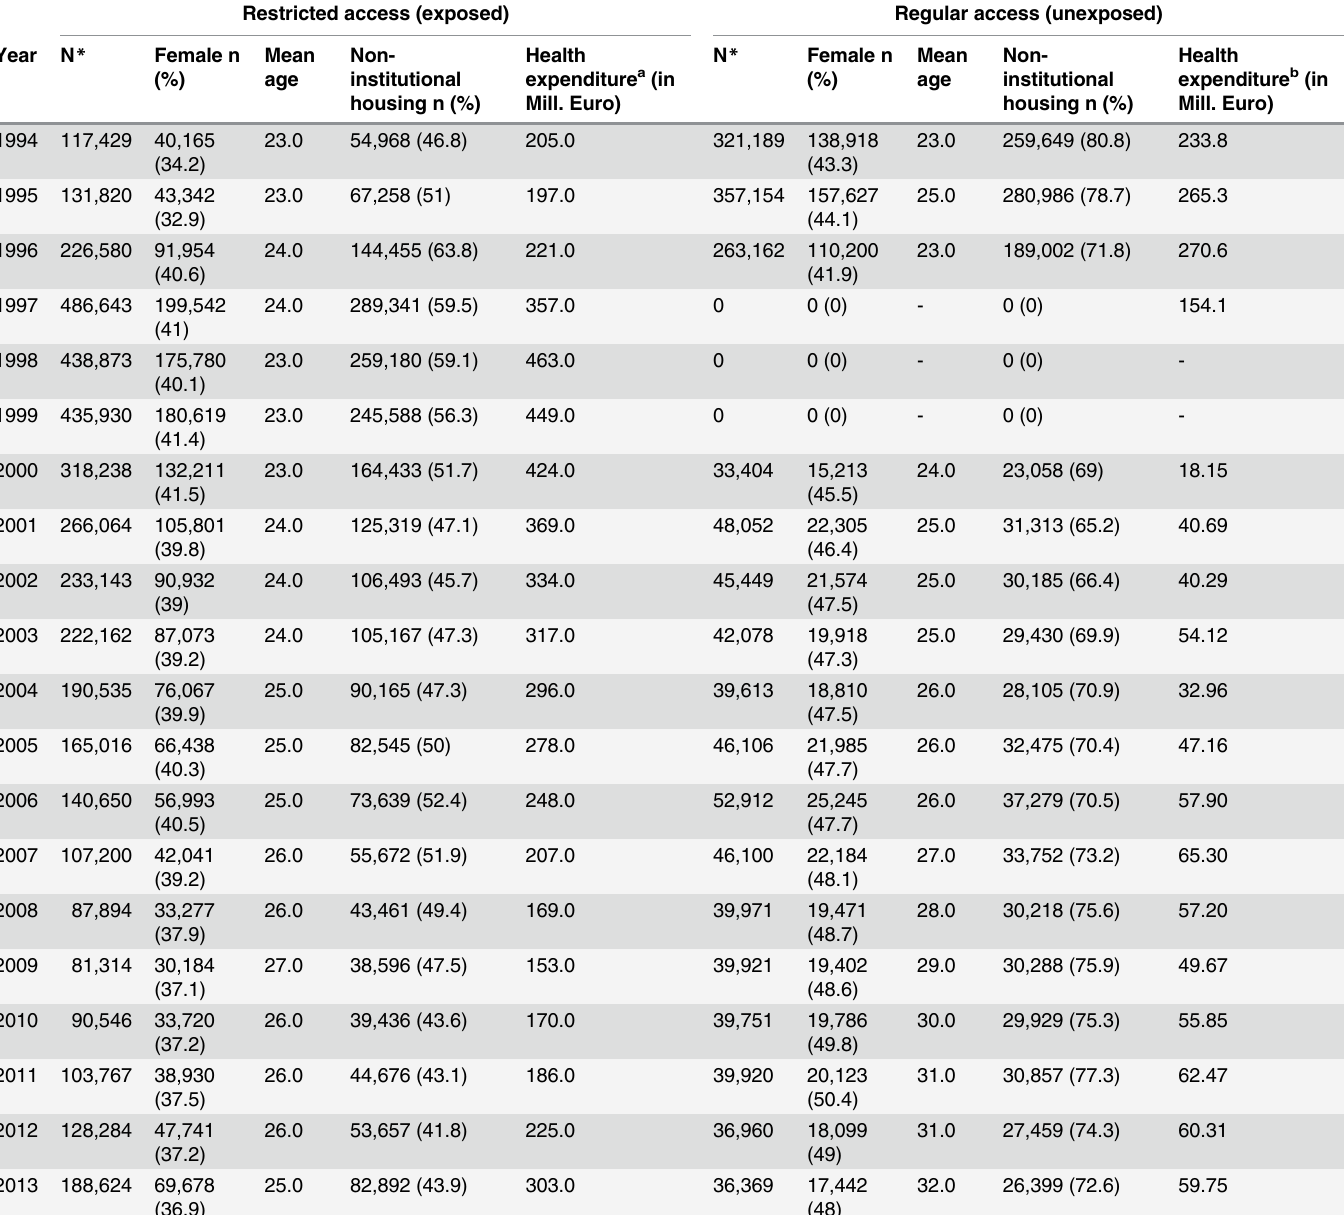
Table 2. Descriptive details of the study population by year and type of